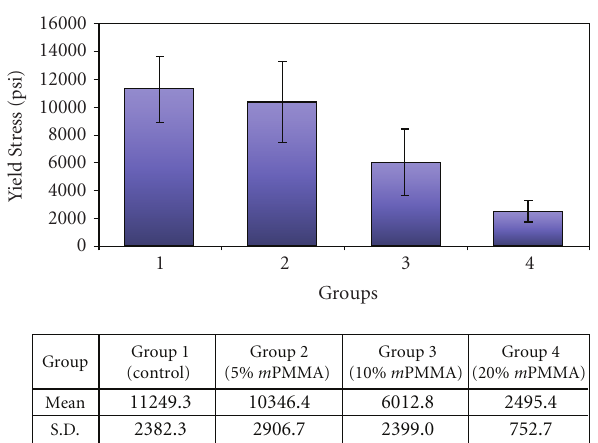
Figure 4: The mean and standard deviation values for Young’s modulus of elasticity for each of the experimental